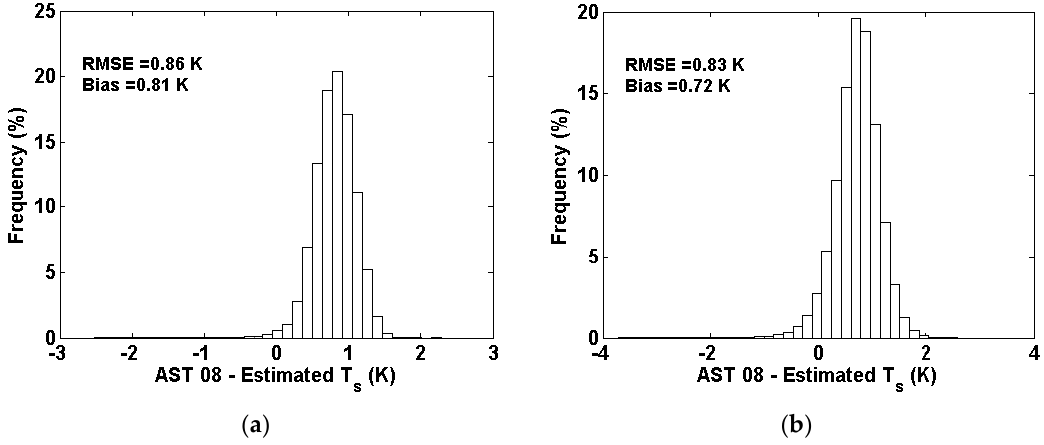
Figure 17. Histograms (( a ) for study area A and ( b ) for study area B) of the difference between AST 08 and the estimated LST from ASTER L1B data using Equations (11) and (12).